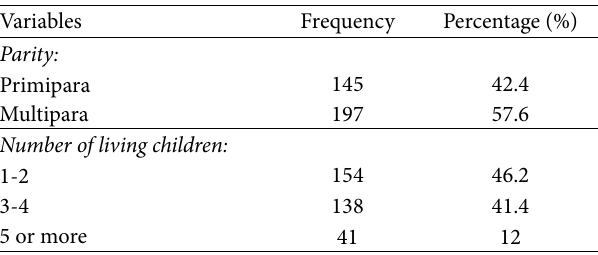
Table 1: Socio-demographic characteristics of pregnant mothers attended ANC follow-up in the Gununo health center, SNNP re- gion, Southern Ethiopia, 2019.